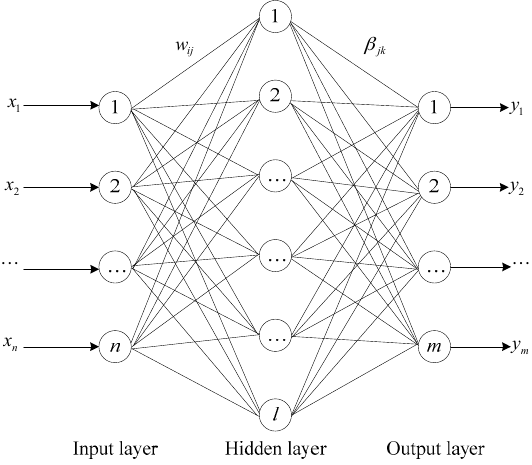
Figure 5. Structure of the single-hidden-layer feed-forward neural network.